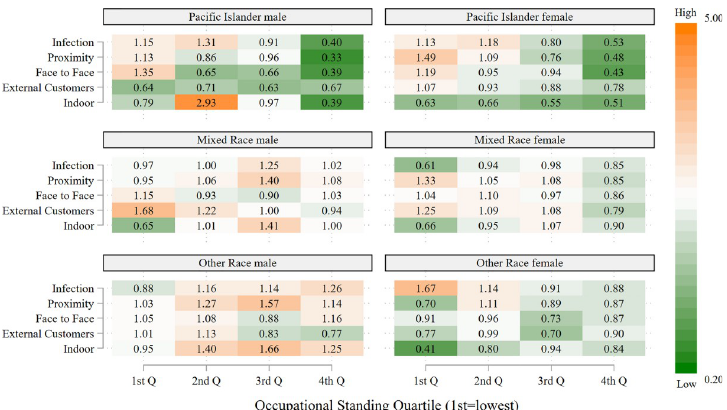
Fig 5. Representation of frontline workers in high-risk occupations relative to representation as frontline workers by occupational standing: Pacific Islander, mixed race, and other race workers, by sex. Data are from the 2018 American Community Survey (ACS). Occupations are considered to be high-risk if the average value for the risk factor in the O � NET data falls in the highest quartile of the occupations in the analysis. Occupational standing (OS) is defined as the percentage of ACS respondents reporting this occupation who completed at least one year of college education. The 1 st OS quartile is the lowest quartile and the 4 th (OS) quartile the highest.